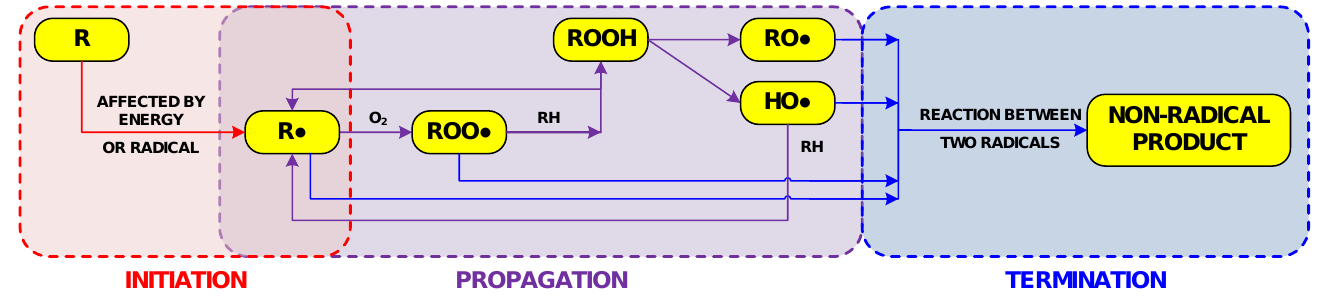
Figure 4. A generalized scheme of the AOP degradation of MP polymer (R).